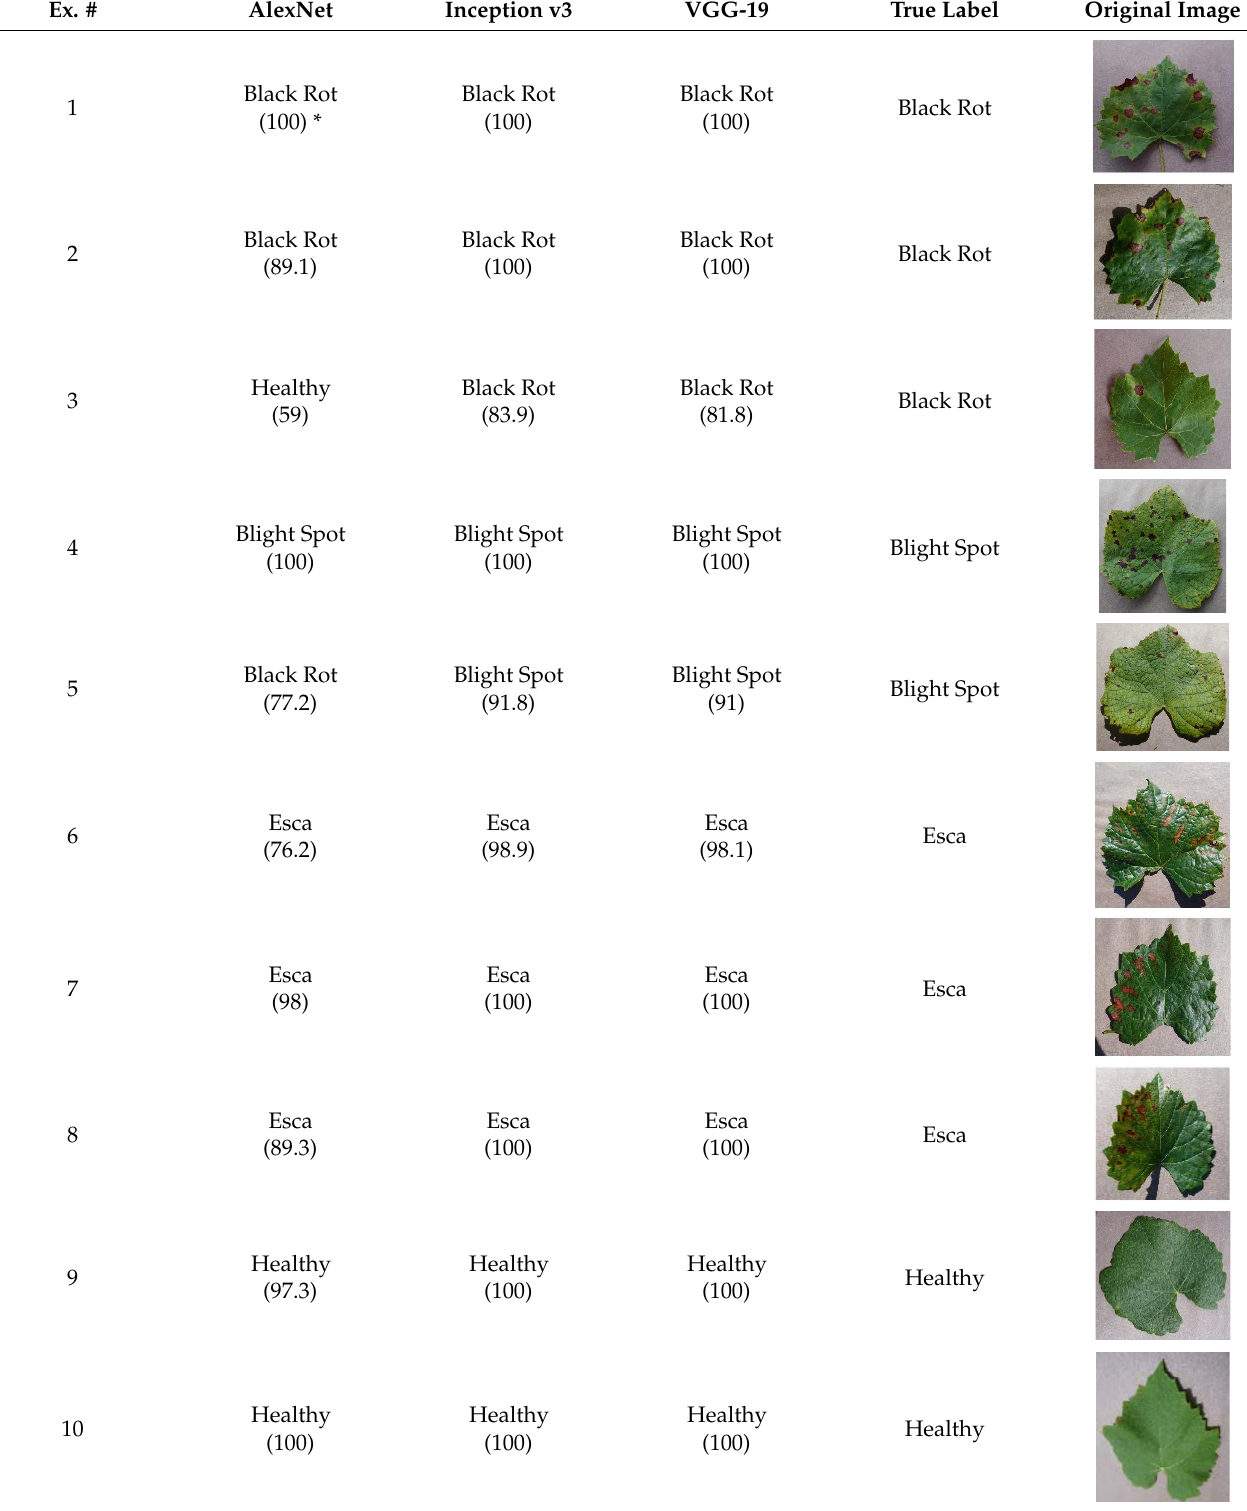
Table 12. AlexNet, Inception v3, and VGG-19 trained with fine tuning and a 3-layer neural network in the last FC layer. Model evaluation (testing phase) gives an example of untrained images from the training distribution (PlantVillage data).